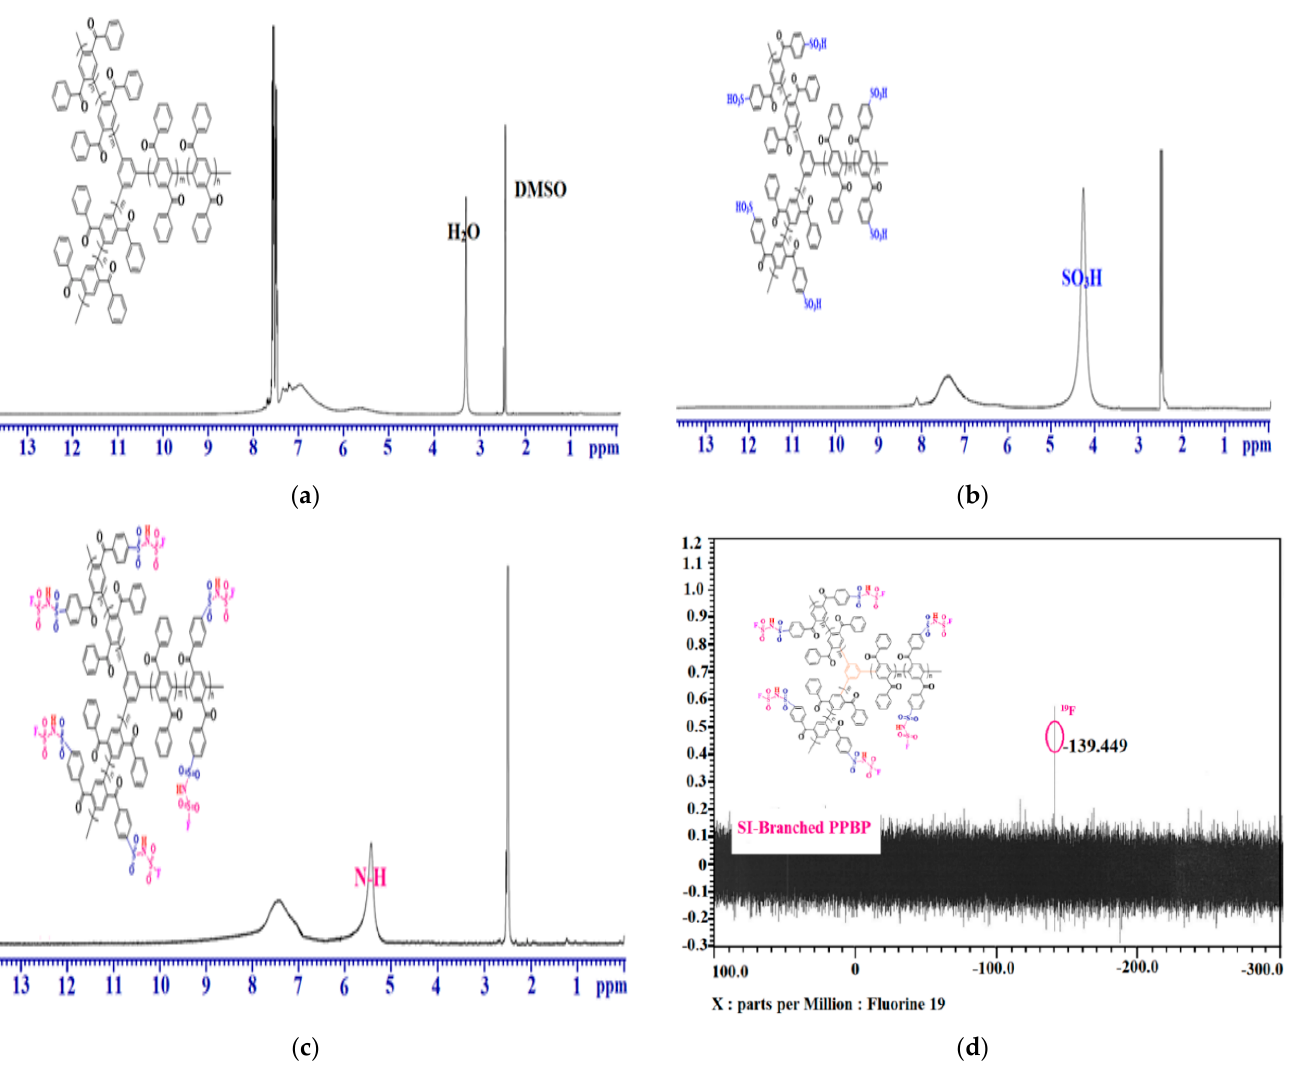
Figure 1. 1 H-NMR of ( a ) branched PPBP, ( b ) S-branched PPBP and ( c ) SI-branched PPBP polymers. ( d ) 19 F-NMR of the SI-branched PPBP polymers.